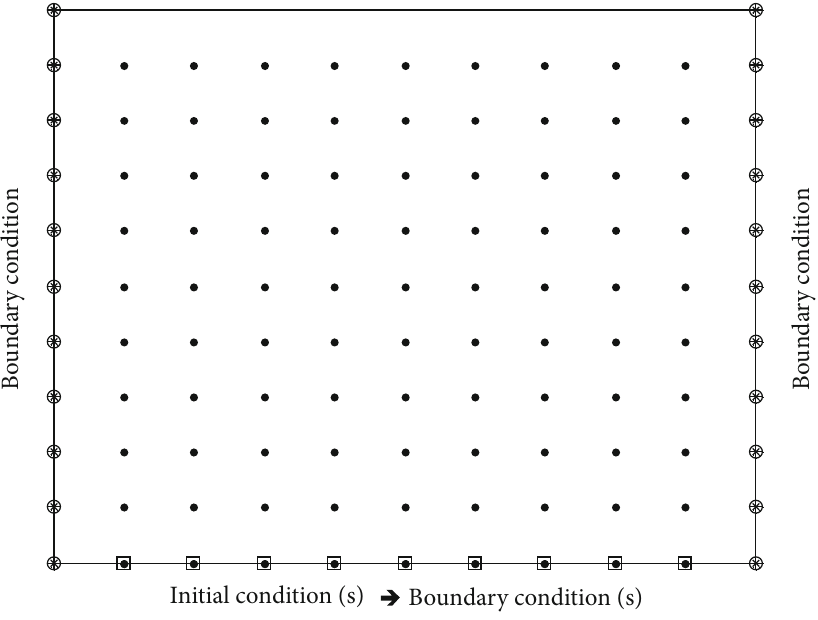
Figure 2: Domain of space-time